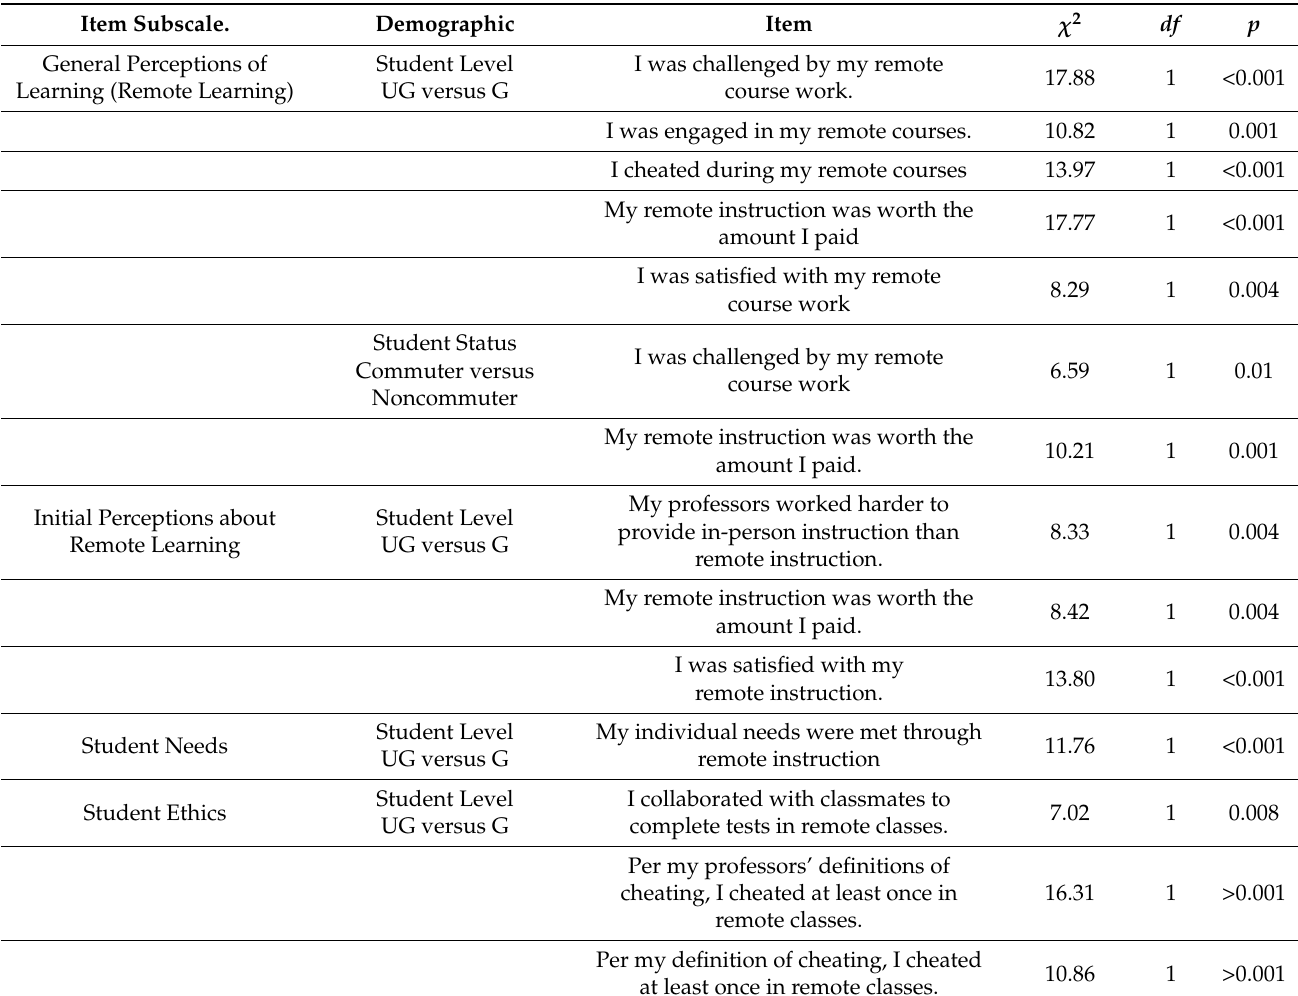
Table 8. Differences in Percentages across Student Level (Undergraduate vs. Graduate). Item